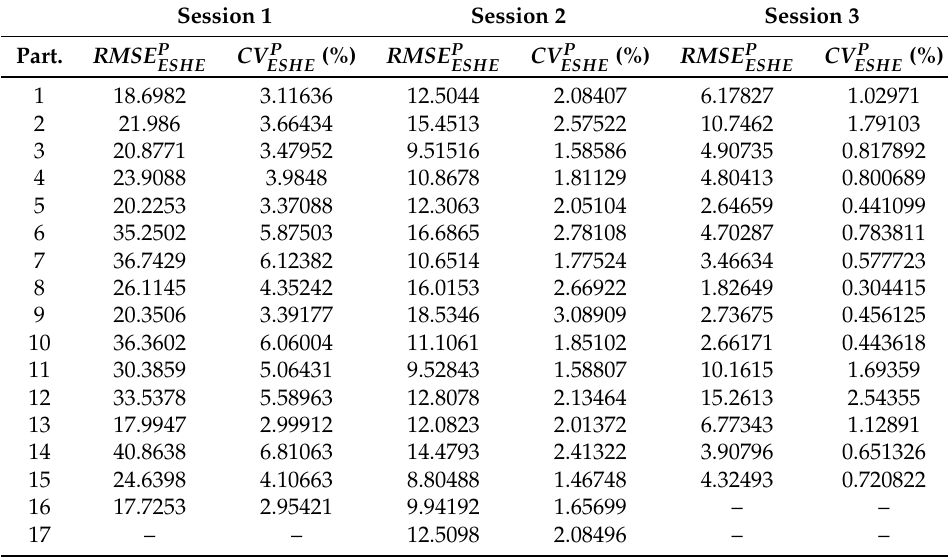
Table 10. Forecast errors of the exponential smoothing with non-monotonic H model ( ESHE ) for the three sessions. Session 1 Session 2 Session